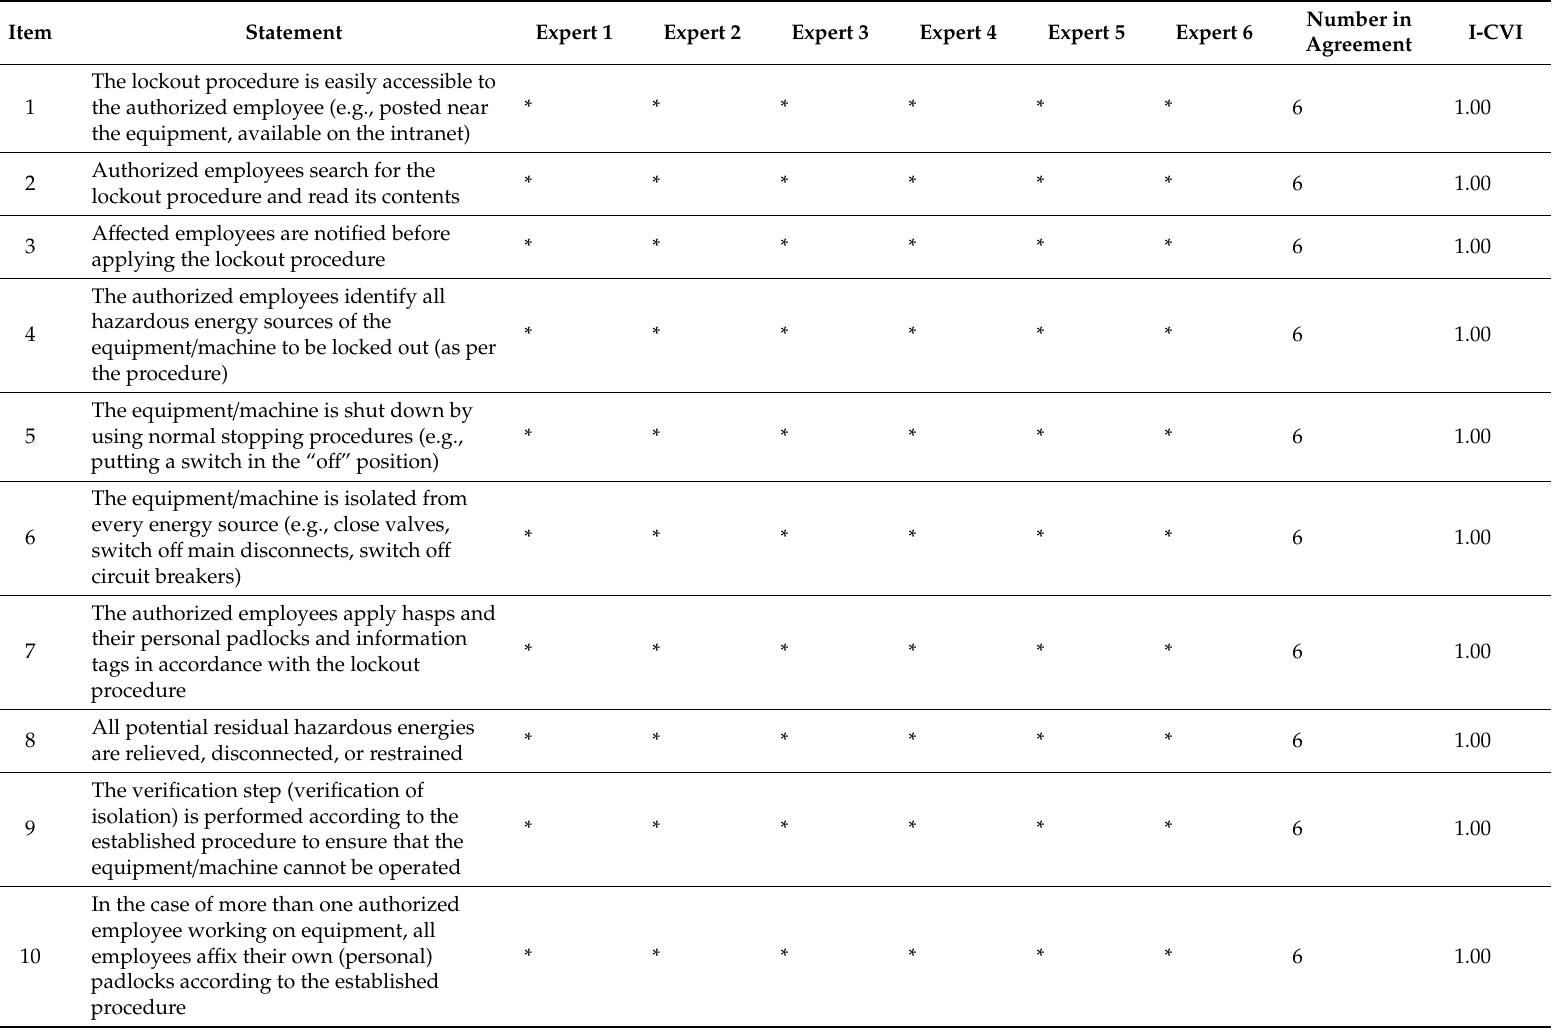
Table A3. Calculation of I-CVI and S-CVI for the initial self-audit tool: Audit of the application of lockout.